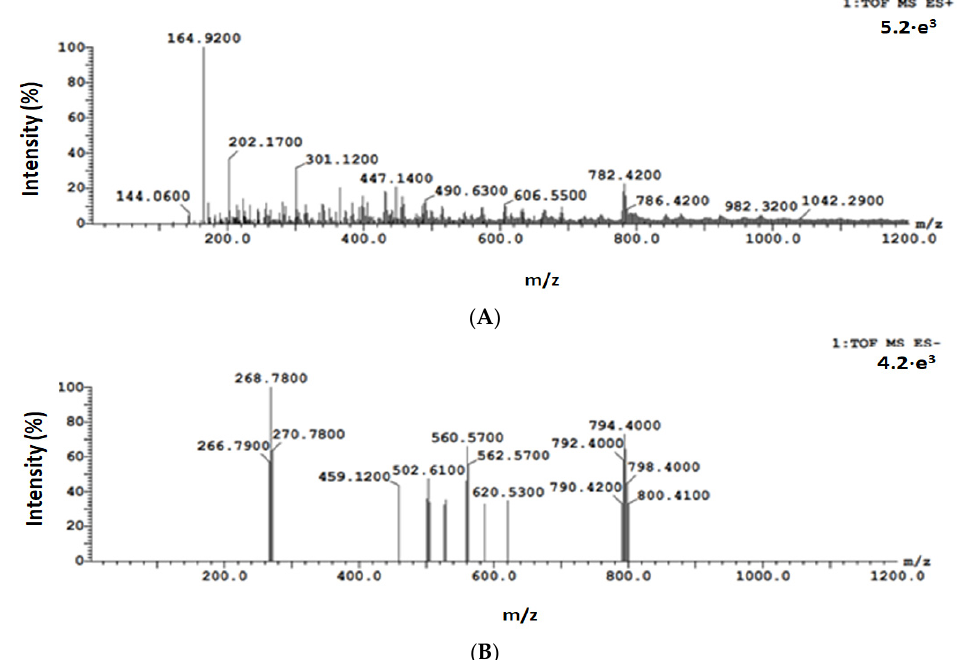
Figure 2. Mass spectra of hydrolysed products after 6 h of enzymatic reaction using Bacillus haynesii. chitinase in positive mode ( A ) and negative mode ( B ).